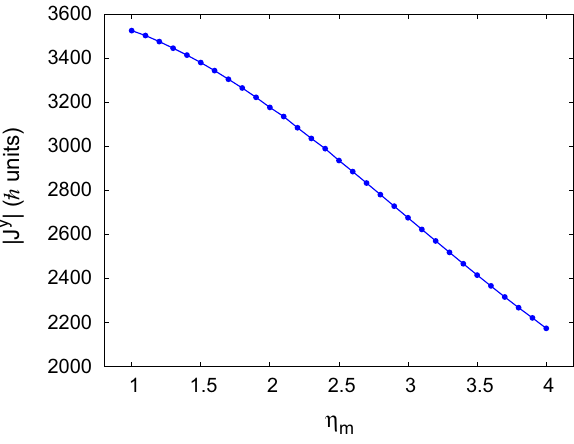
Fig. 9 Angular momentum (in ¯ h units) of the plasma with Bjorken initial conditions as a function of the parameter η